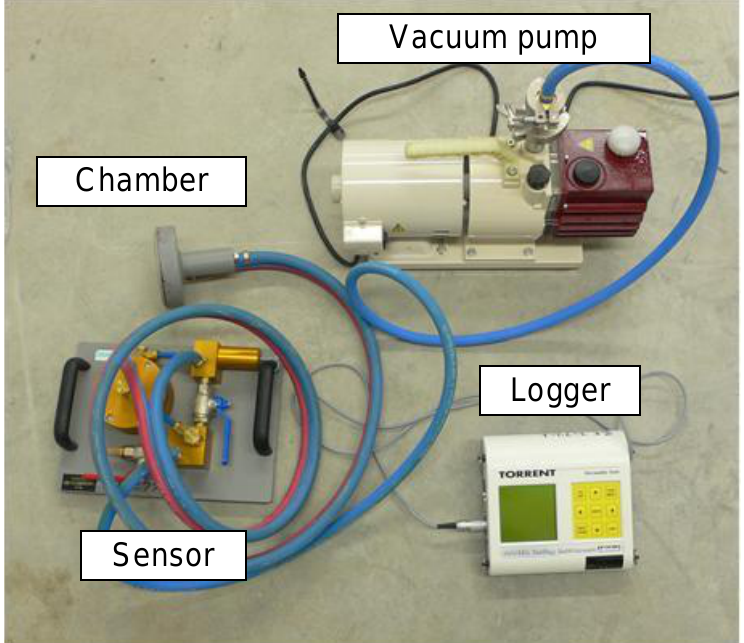
Figure 3. Torrent Permeability